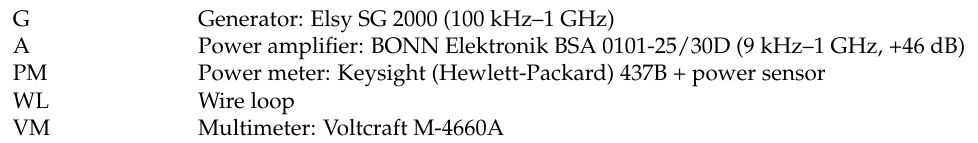
Figure 8. Setup for measuring the DC voltage of the varactor. Table 3. The components used in the configuration of the DC voltage measurement.